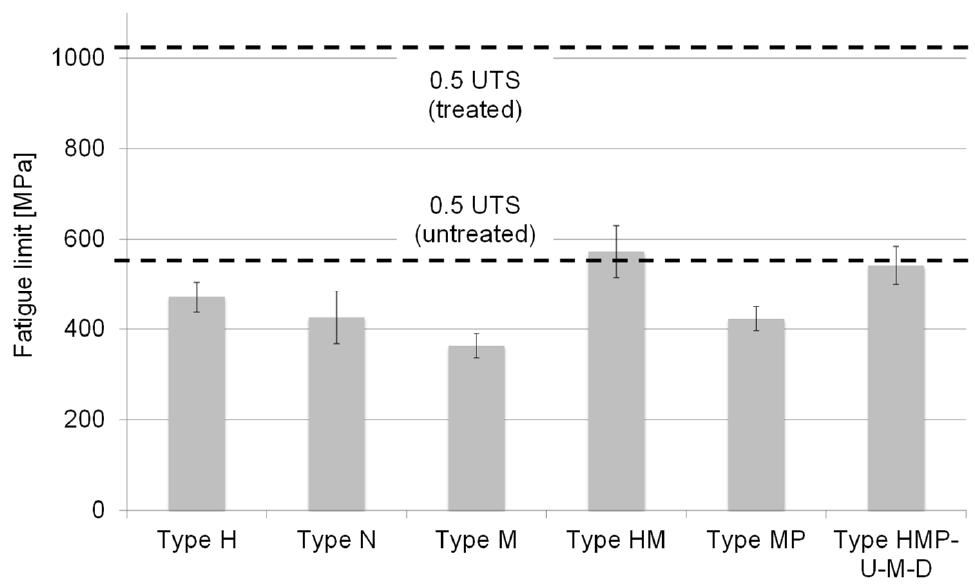
Figure 7. Fatigue limit for infinite life for HMP-U-M-D compared to those of the complete experi- mental campaign (with reference to [23]). Table 5. Failure–not-failure sequence at staircase involving specimens of Sets HMP-U-M-D.